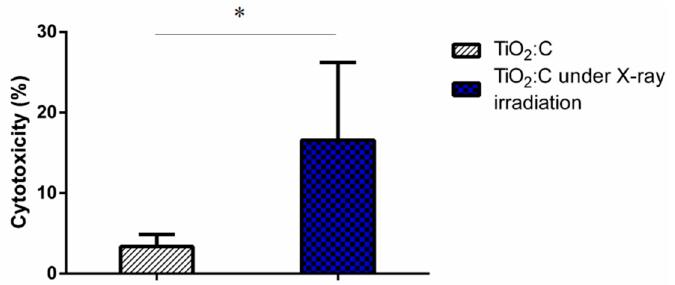
Figure 4. The photodynamic therapy (PDT) efficacy of TiO 2 :C exposed to X-ray irradiation in terms of toxicity by LDH assay ( t -test, mean ± SD, n = 6, *: p -value < 0.05).